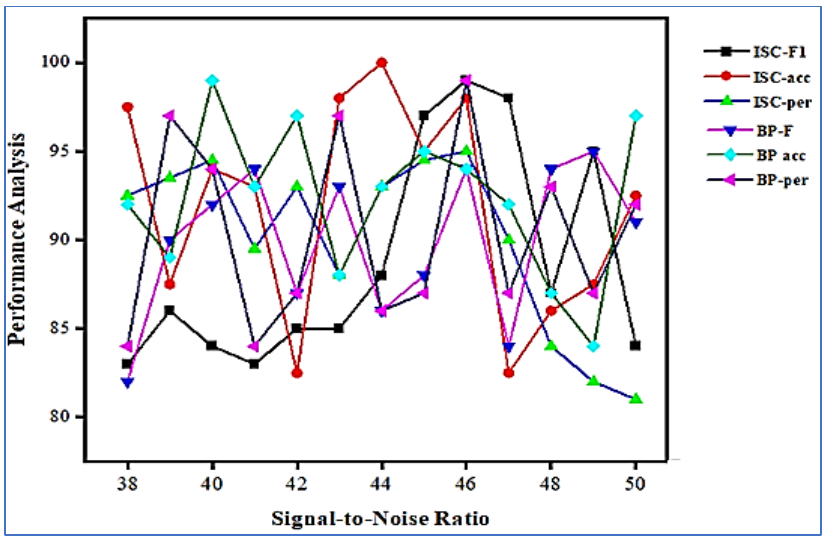
Figure 4. Performance analysis comparison of higher education vocational courses with different signal-to-noise ratios.